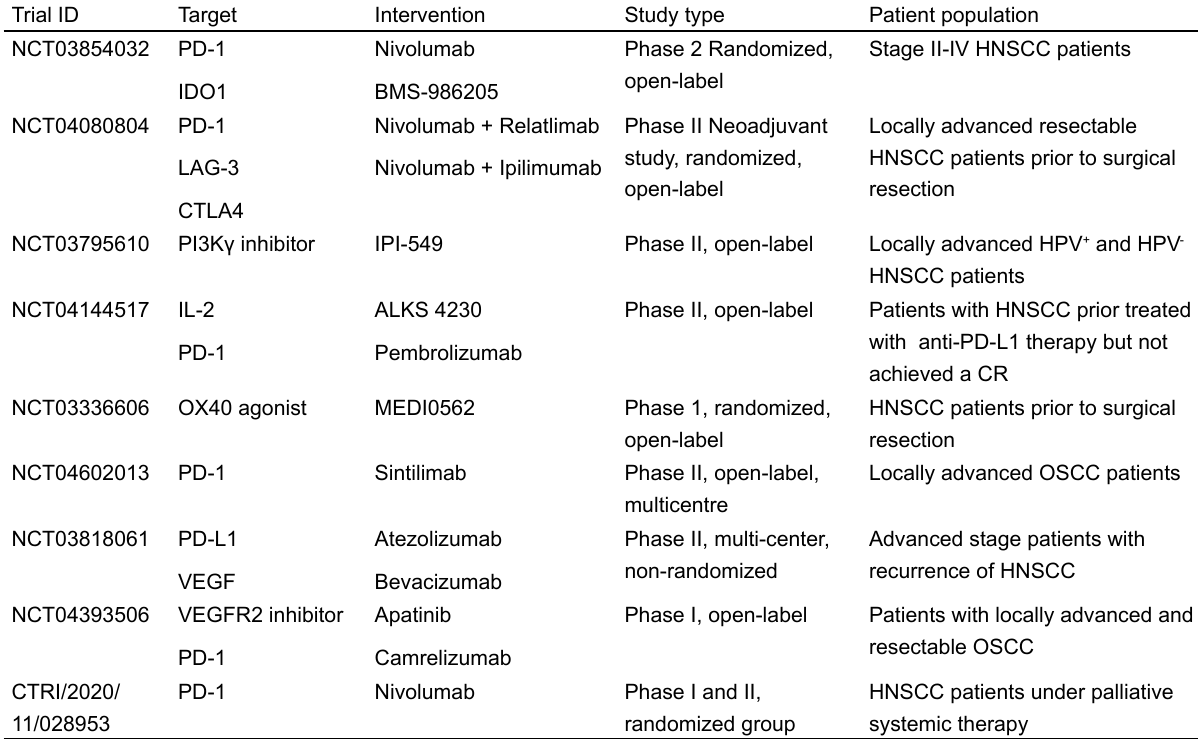
Table 1. Immunotherapeutic drugs in clinical development for head and neck cancer [196, 197] ( continued ) Trial